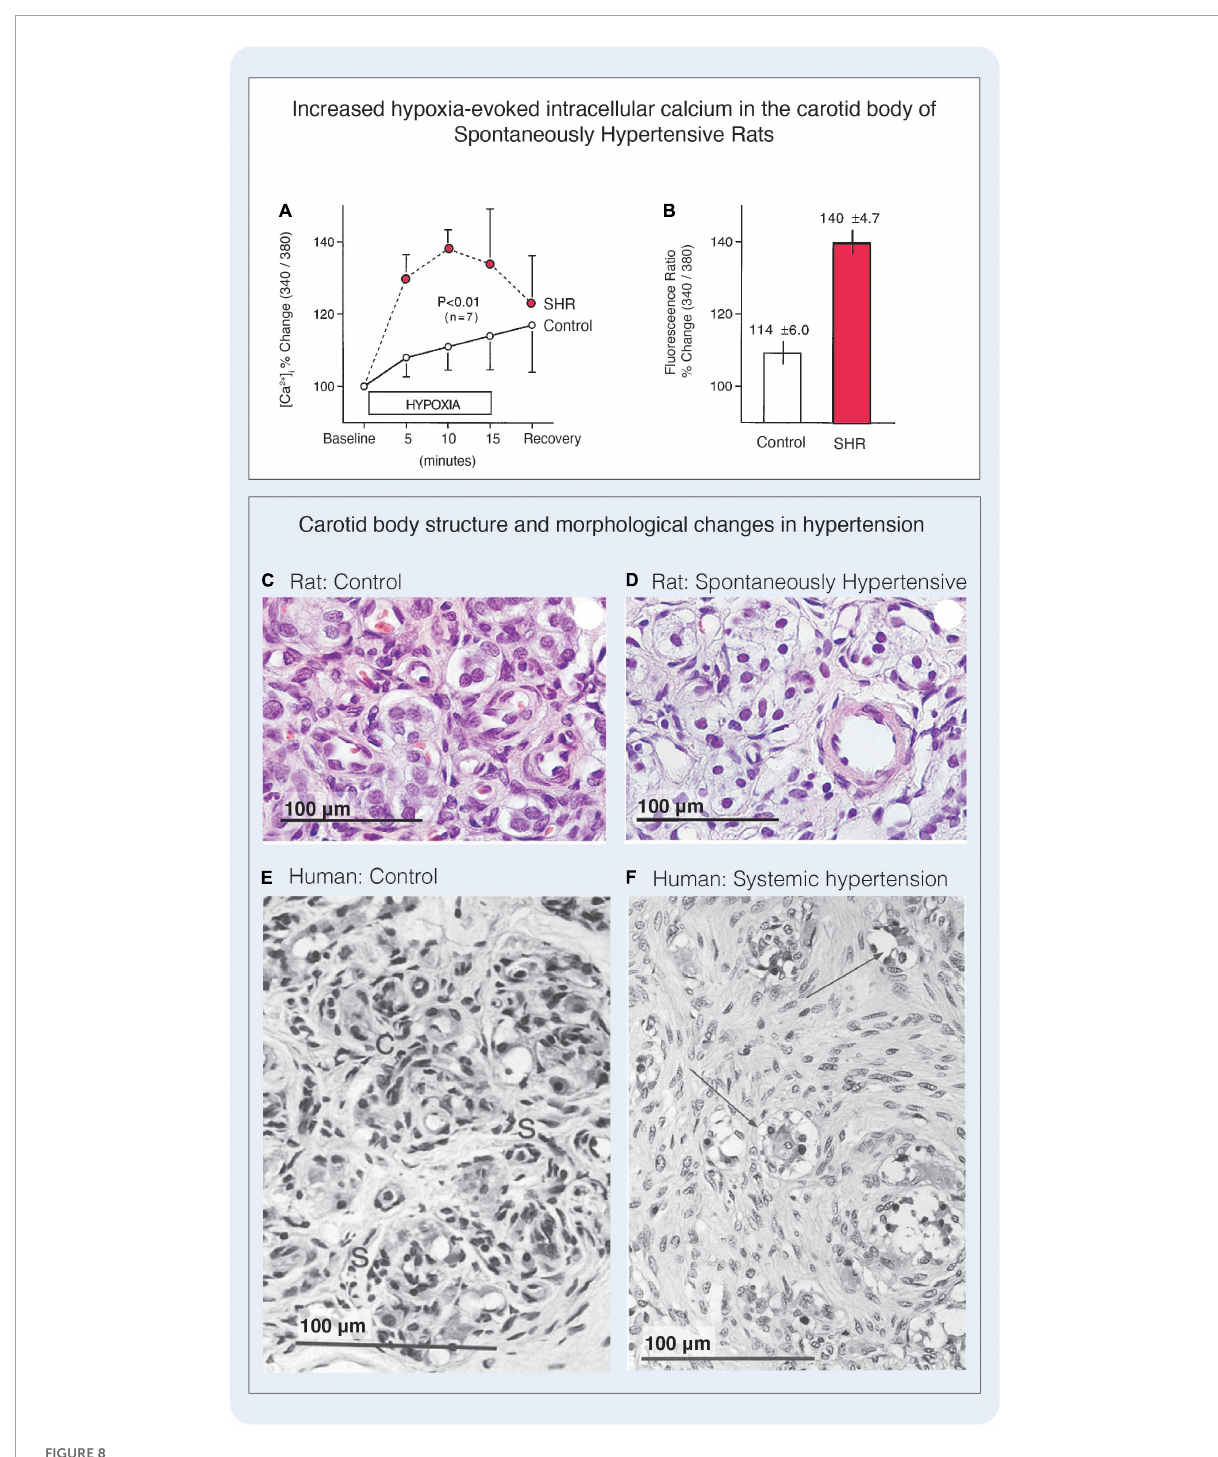
FIGURE8 Excitability and cellular changes in the carotid body in hypertension. (A) Hypoxia-induced intracellular Ca 2 + is elevated in type I cells of SHR compared with levels measured in normotensive rats (‘Control’). Cells were loaded with Fura-2 and intracellular Ca 2 + was measured via sequential changes in the fluorimetric ratio (340/380 nm) during 15-min exposure to hypoxic superfusion (PO 2 , 55 mmHg). Simultaneous paired hypoxic exposure shows greater hypoxic responses in carotid bodies of the SHR strain compared with the F-344 rat. n = number of rats. (B) Peak Ca 2 + responses to hypoxia were greater in SHR carotid bodies compared with F-344 rats. Figures A and B reproduced with permission from Weil et al. (1998). (C,D) Haematoxylin and Eosin (H&E) stain showing carotid body structure in control normotensive rats and